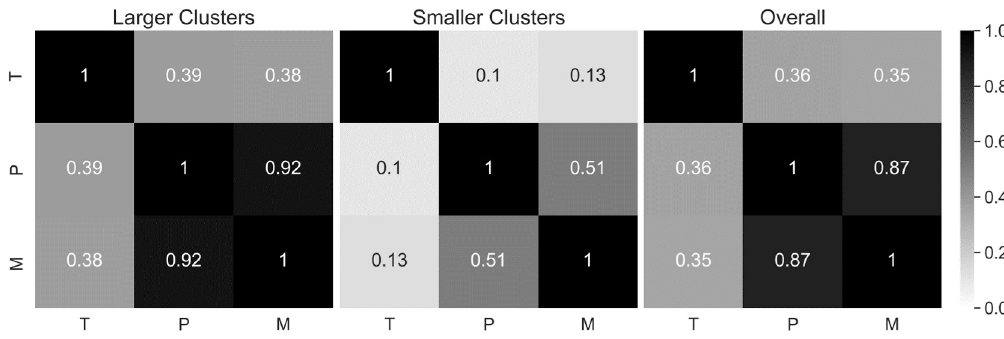
Fig 2. Normalized Jaccard similarity between the clusterings of different datasets. T, P, and M, represent the Transcriptomic, Proteomic or Metabolomic results respectively. The normalized Jaccard accounts for the varying sample sizes for each subtype.